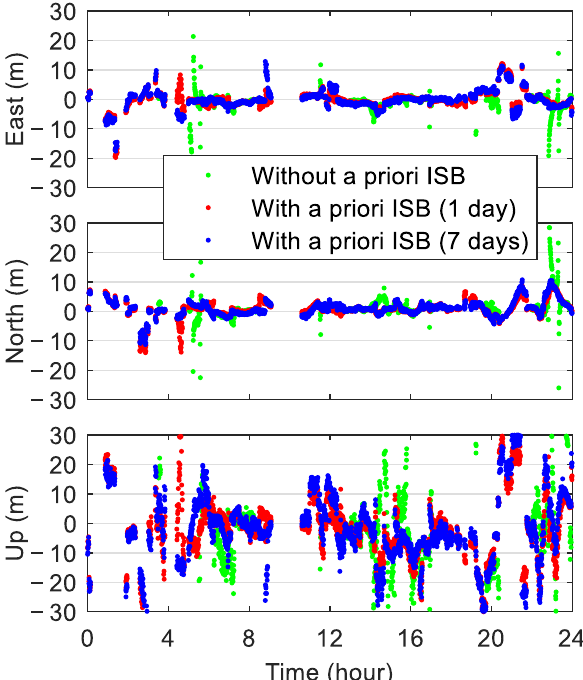
Figure 11. Epochwise positioning errors of four-system integrated SPP with and without a priori ISB constraints under a cutoff elevation of 50° at station ABMF on DOY 48 of 2020.